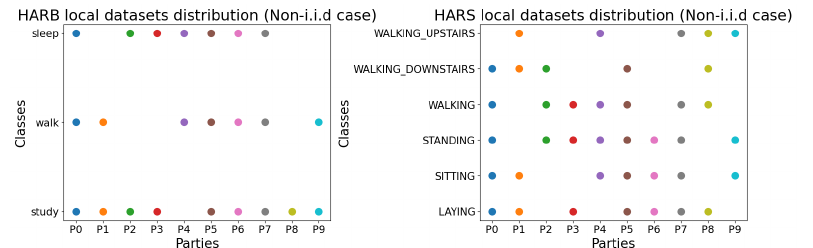
Figure 6. From left to right, the figures show the non-i.i.d distribution in the federated learning experiments of HARB and HARS datasets, respectively. Points show whether a party/client possesses a particular class in his local dataset D i or not. For example, in the HARS dataset, the party P 2 has three classes out of six. All clients are tested against all classes (The test dataset D t is the same for all parties). Each color in the scatter plot refers to a